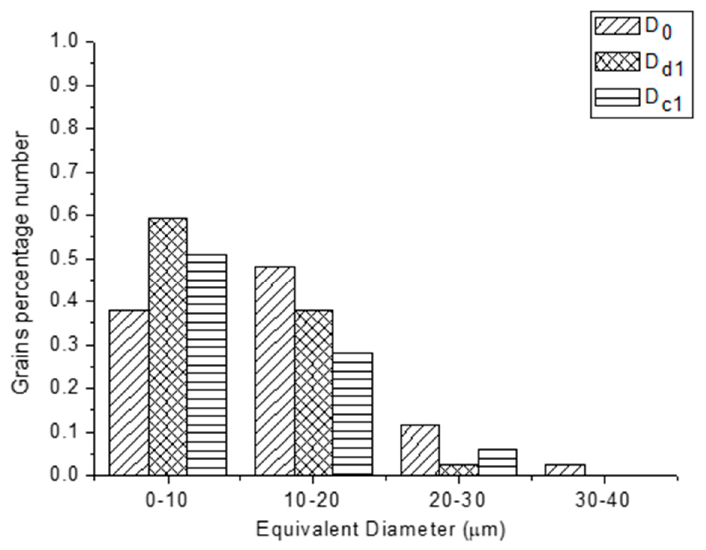
Figure 6. Distribution of the grain equivalent diameter evaluated in the L1 and L2 sections.